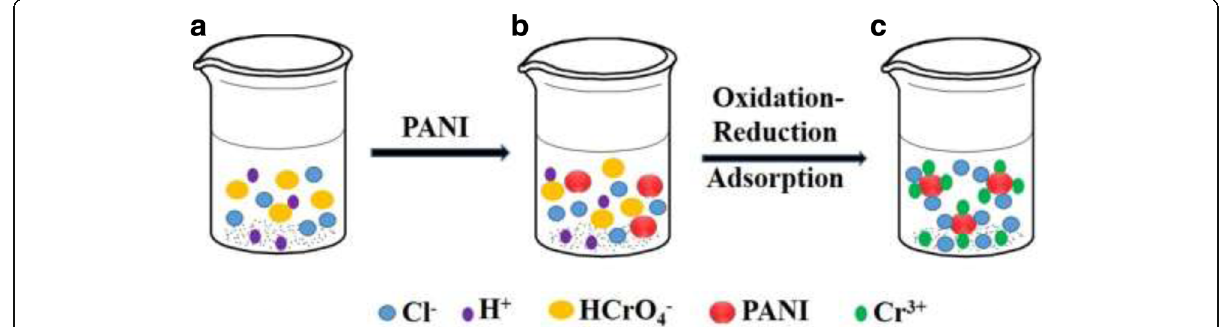
Fig. 9 The schematic diagram of Cr (VI) removal. a Wastewater containing Cr (VI) under acidic conditions, b adding PANI to wastewater containing Cr (VI), and c wastewater of Cr (VI)